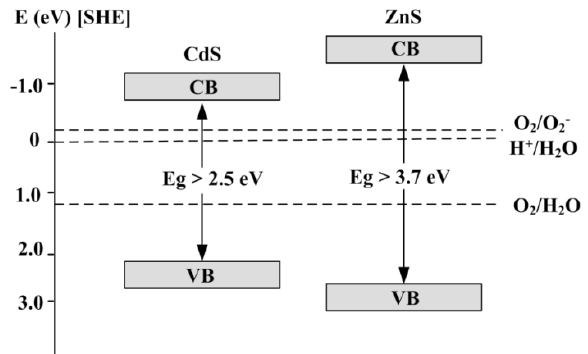
Figure 9. Schematic band structure of ZnS and CdS